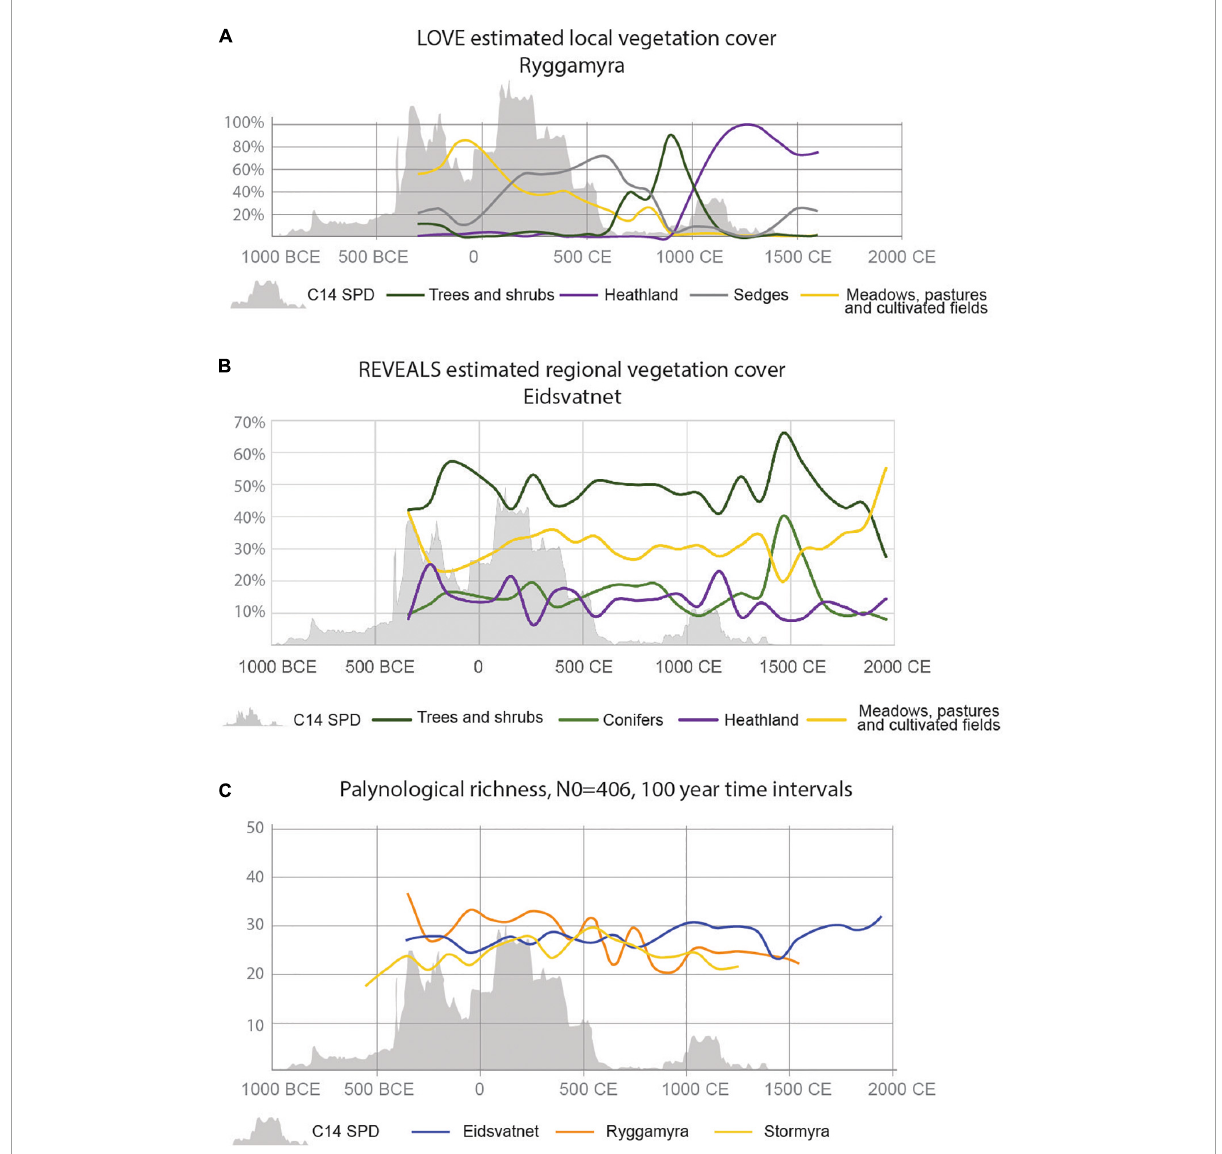
FIGURE7 Summed probability distribution (SPD) shown in relation to (A) REVEALS estimated vegetation cover Eidsvatnet, (B) LOVE estimated vegetation cover Ryggamyra, and (C) palynological richness (estimated number) in 100-year time intervals at the different